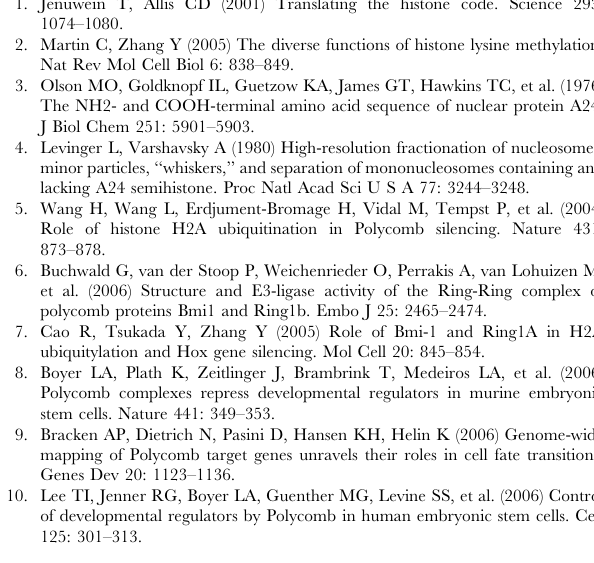
Table S2 Bmi1-dependent uH2A peak regions as determined by TIROE.